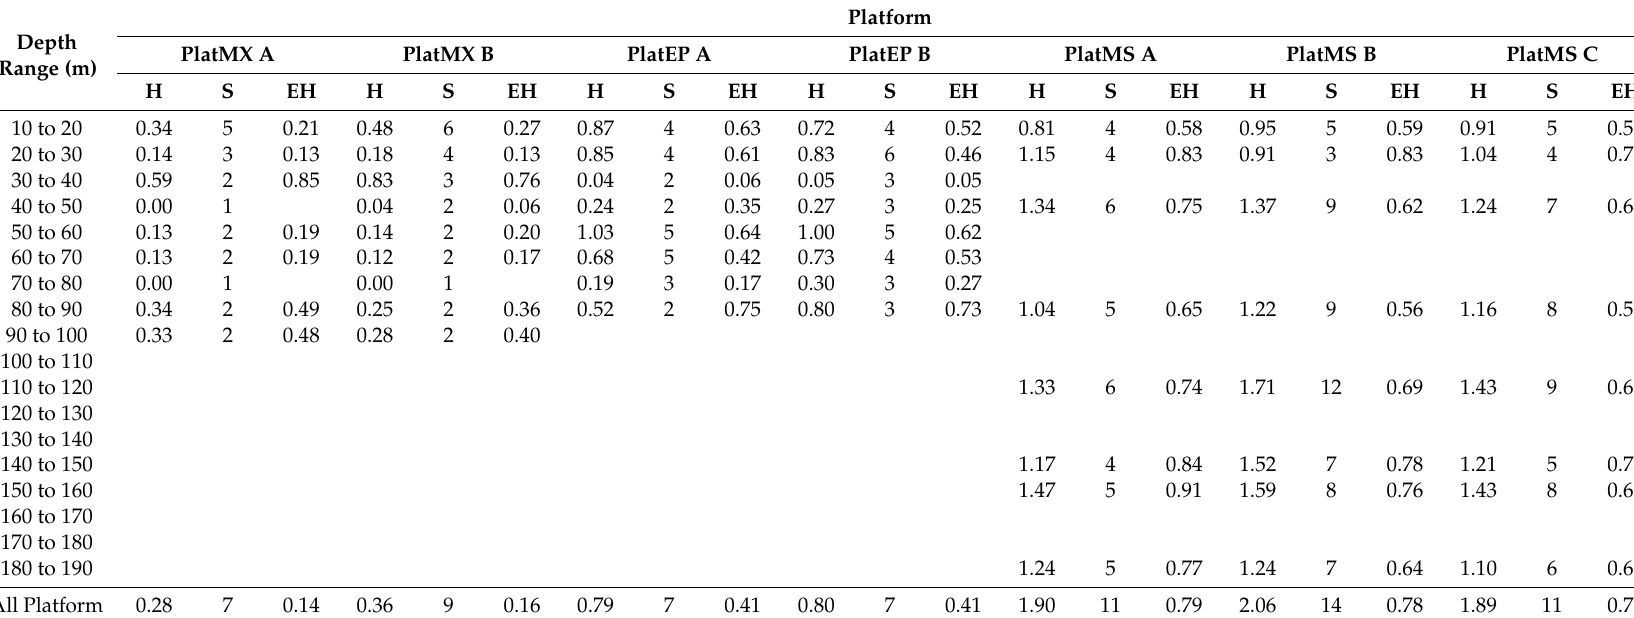
Table 5. Shannon-Wiener species diversity index (H), total number of species (S) and Evenness (EH) per platform and testing methods (A, B and C) at 10 m depth